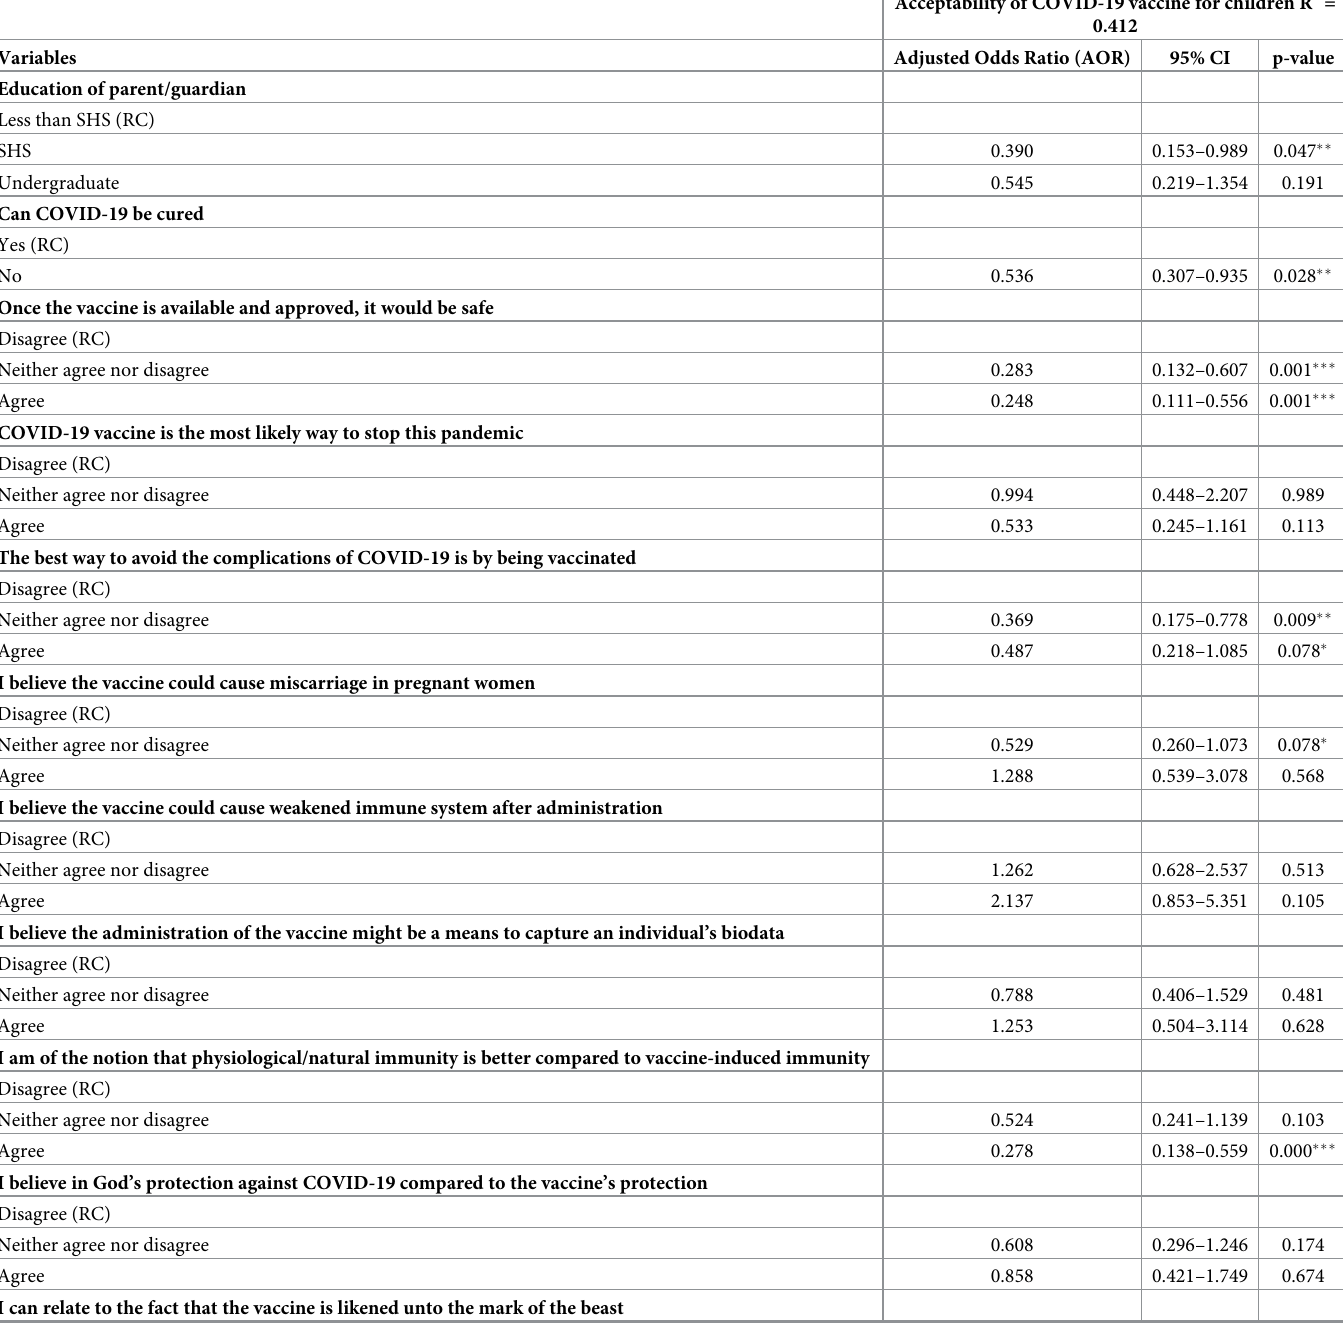
Table 5. Logistic regression model of acceptability of COVID-19 vaccine for